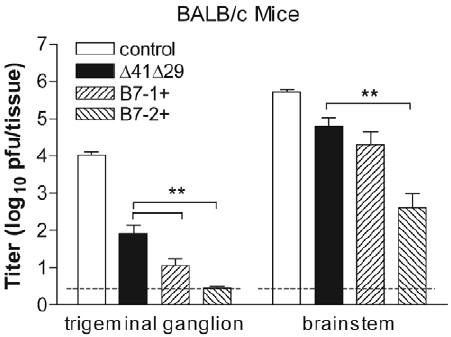
Figure 7. Acute replication of challenge virus in the nervous system. BALB/c mice were immunized with the medium dose of the indicated virus or with control supernatant and challenged by the corneal route one month later. TG and brainstems were dissected 5 d post-challenge, and virus titer in them was determined by standard plaque assay. Data represent the geometric mean 6 SEM for a total of 20 TG and 10 brainstem samples per group, compiled from 2 independent experiments with similar results. **, P , 0.001 compared with D 41 D 29. Dashed line indicates limit of detection in the plaque assay. (P , 0.001 for all virus groups compared with control supernatant for TG; P , 0.01 to 0.001 for B7-expressing viruses compared with control supernatant for brainstem).